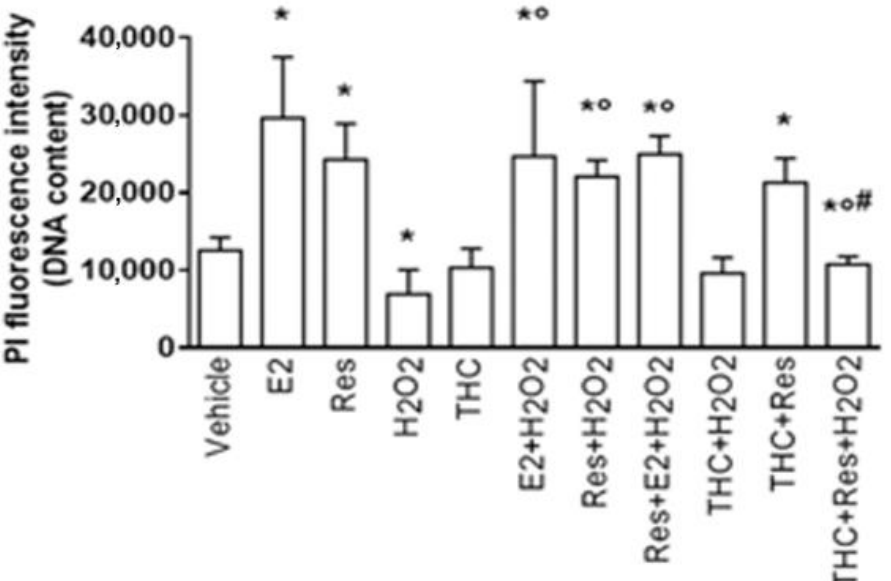
Figure 6. E2 and Res protective effect on SH-SY5Y cell vitality against H 2 O 2 . SH-SY5Y cells were treated with (R,R)-THC (10 − 6 M) for 1 h before 24 h stimulation with vehicle (DMSO 1: 1000, v : v ), E2 (10 − 9 M), Res (10 − 7 M) and H 2 O 2 (5 × 10 − 5 M). Cell vitality has been evaluated by the propidium iodide (PI) assay, as described in the Section 4. The data represent the mean ± SD of at least six different experiments. p < 0.01 was calculated with Student’s t -test with respect to the cells treated with vehicle (*), H 2 O 2 ( ◦ ), and Res (#).